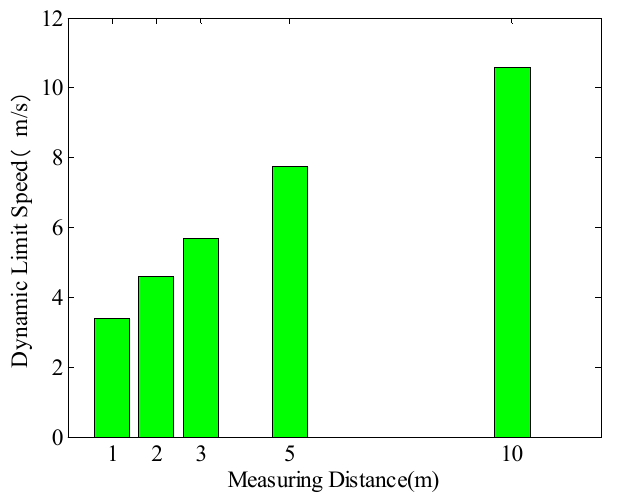
Figure 5. The measurement relationship between dynamic limit speed and distance. Under the dynamic state, after setting the equal spacing for the laser tracker, the actual spacing is greater than the set one. Figure 6 shows the relationship between the dynamic limit speed and the actual measured interval. When the circular trajectory generator is at low speed, the difference between the two is insignificant, but the difference becomes great with the speed increase. The larger the actual measurement spacing, the fewer the measurement points. It can be seen in Table 1 that the equal spacing of the laser tracker is 5 mm. The actual spacing is 7.17 mm at the dynamic limit speed of 3.40 m/s. When the speed is set to 4.60 m/s, the actual spacing is 6.47 mm.